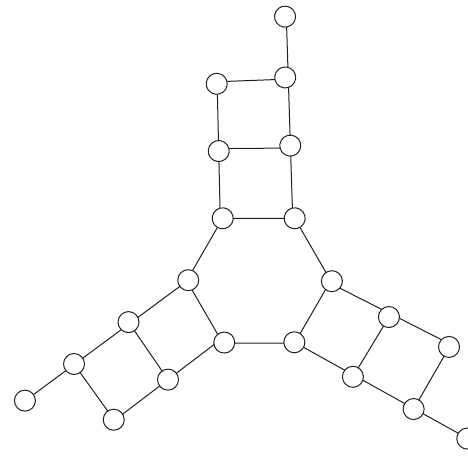
Figure 1: Lin’s example L of a bipartite 3-semiregular graph with M( L ) < Z( L